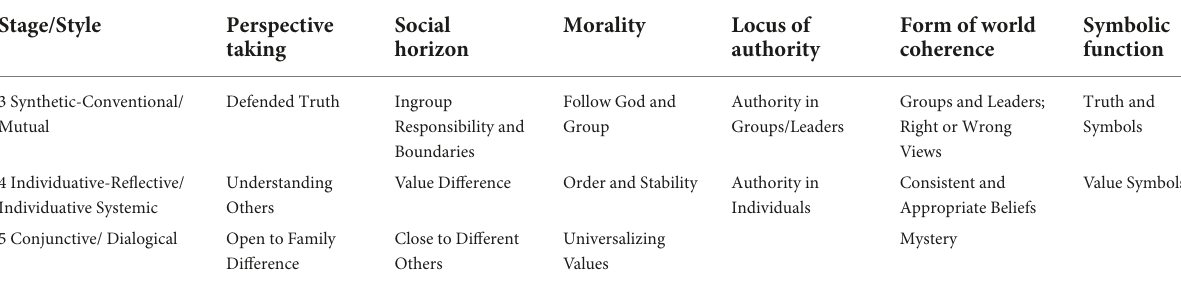
TABLE 6 Summary of stage/style factors that emerged for aspects of faith